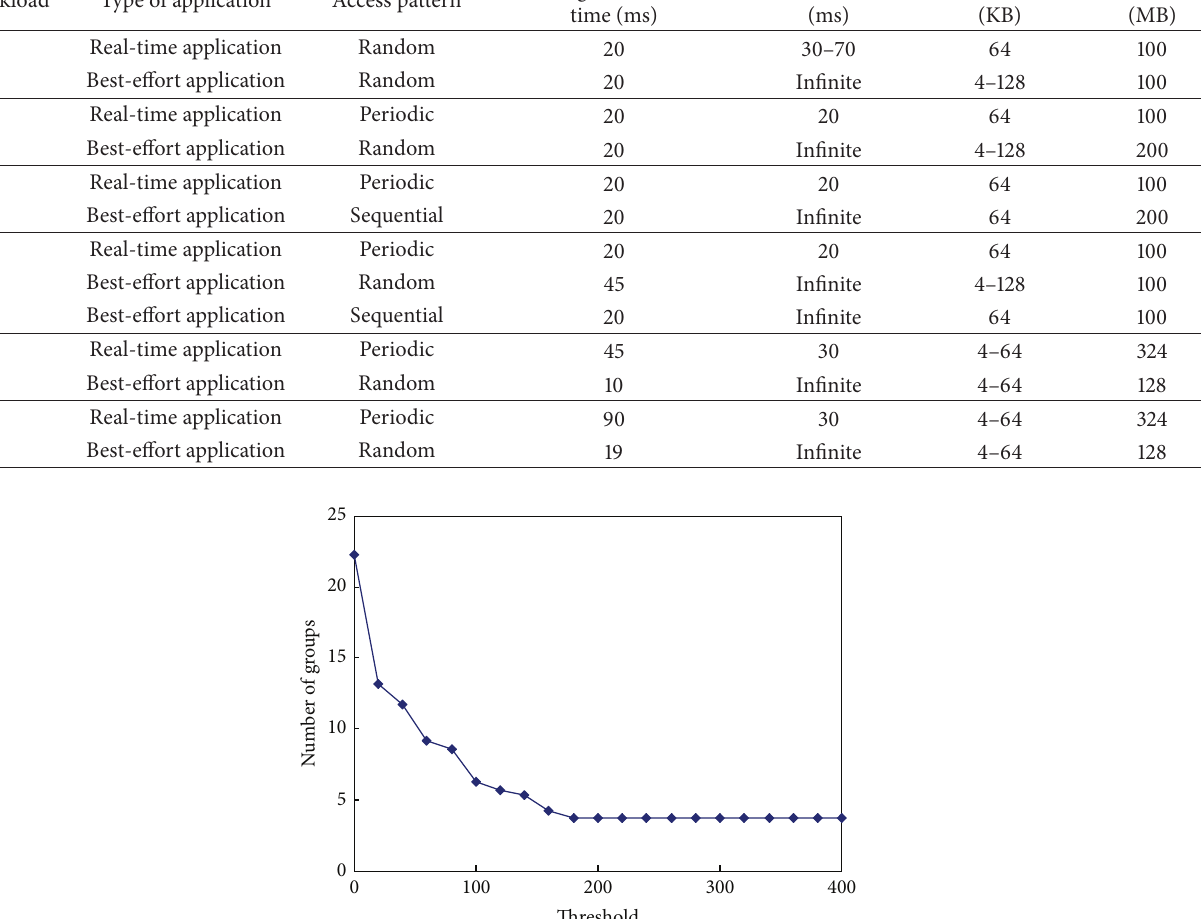
Figure 3: The number of groups after grouping adjacent best-effort requests. The searching space is significantly reduced by the grouping.